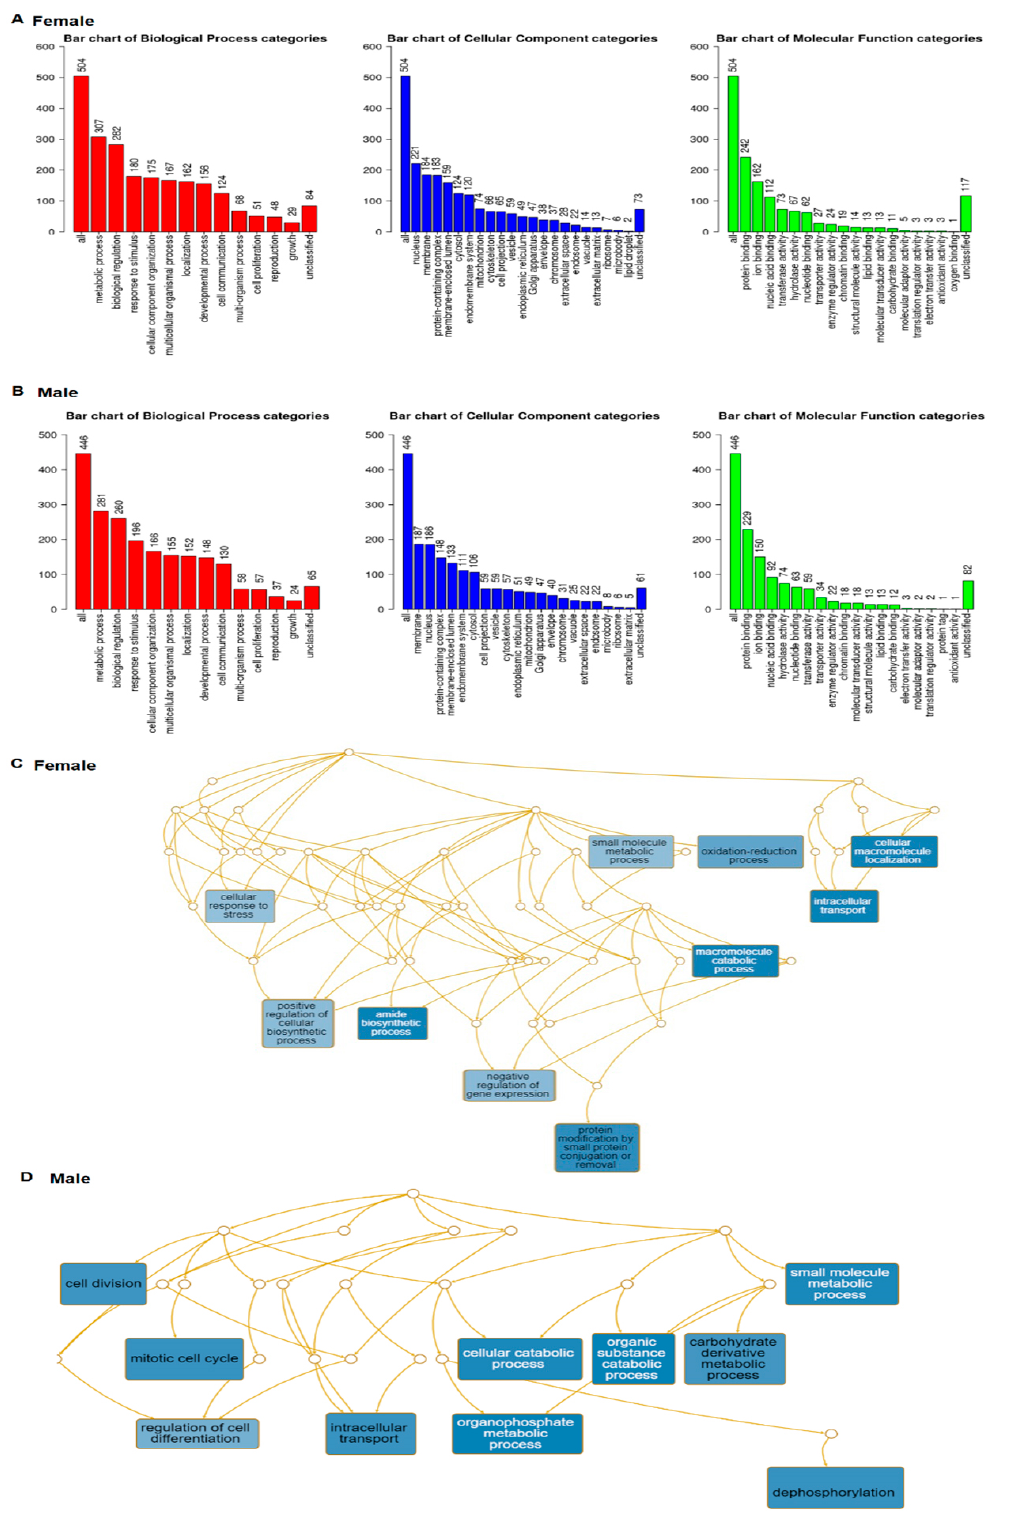
Figure 5. Weighted set coverage of Ace2 pathways between females and males. Each Biological Process, Cellular Component and Molecular Function category is represented by a red, blue and green bar, respectively. The height of the bar represents the number of IDs in the functional category and. ( A ) Numbers of genes involve different pathways of Ace2 in the female. ( B ) Numbers of genes involve different pathways of Ace2 in the male. ( C ). pathway network of Ace2 in the female. ( D ). pathway network of Ace2 in the